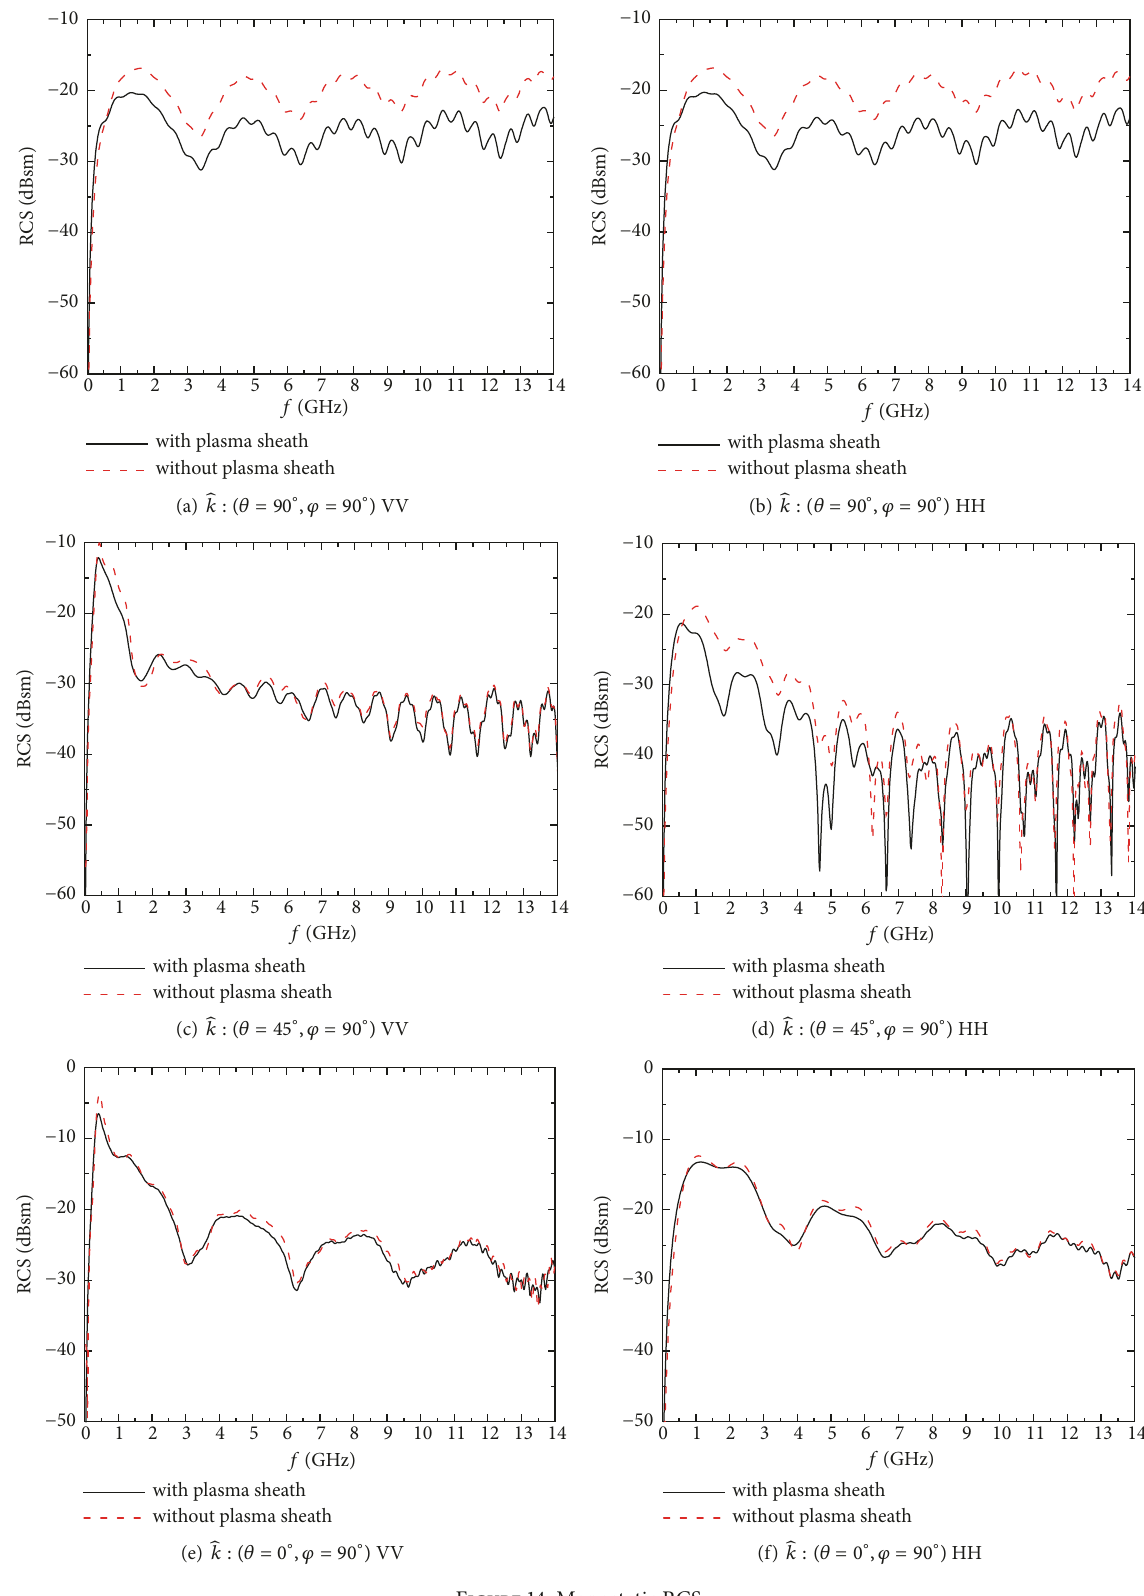
Figure 14: Monostatic